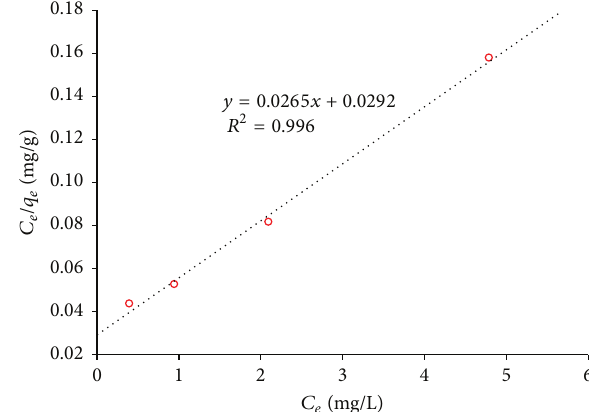
Figure 10: Langmuir isotherm plots for adsorption of copper ions onto CaHBSD.